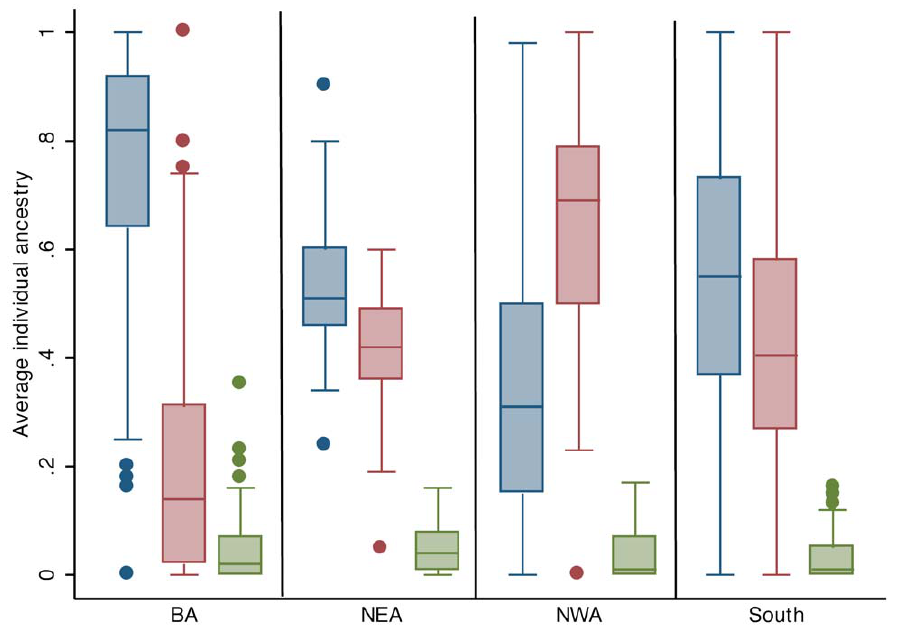
Figure 2. Box plots of average individual ancestry by four major Argentine regions. The blue boxes represent the European component, the red boxes the Indigenous American component and the green boxes the African component. BA=Buenos Aires province; NEA=Northeast; NWA=Northwest; South=South.